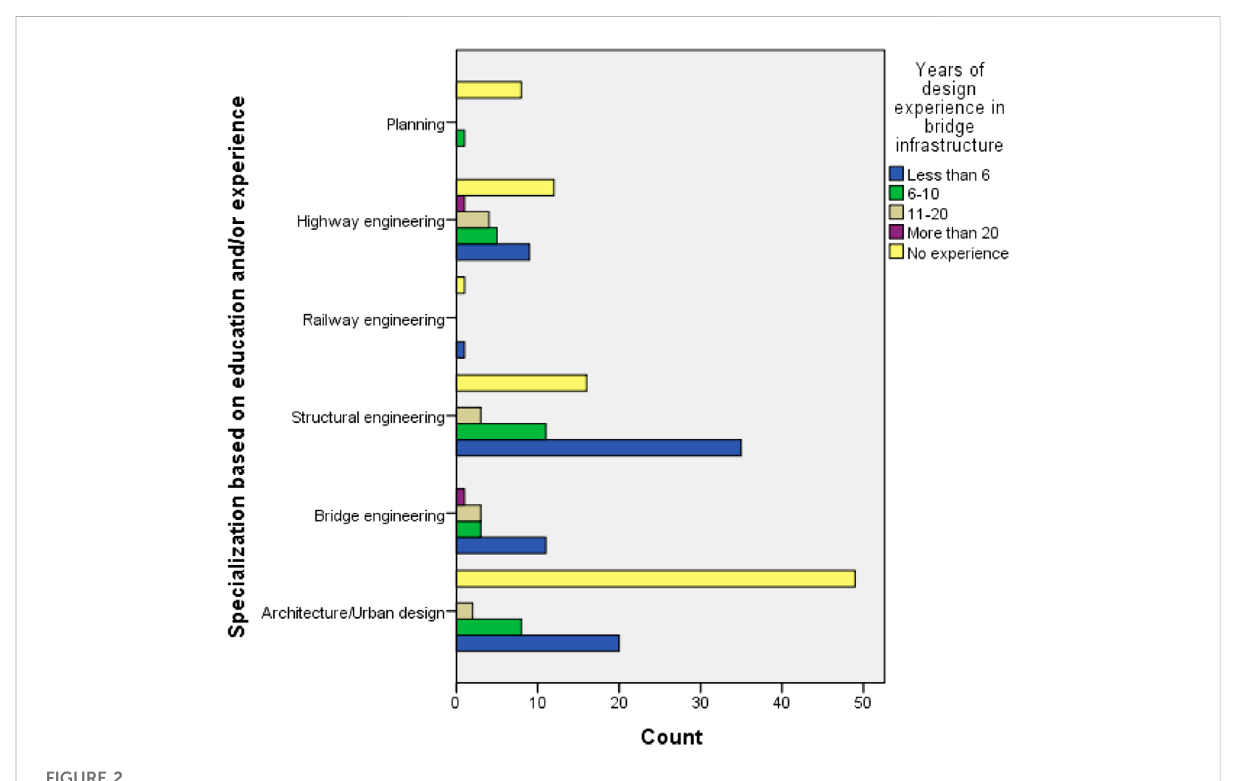
FIGURE 2 Cross-tabs of specialization and years of experience.